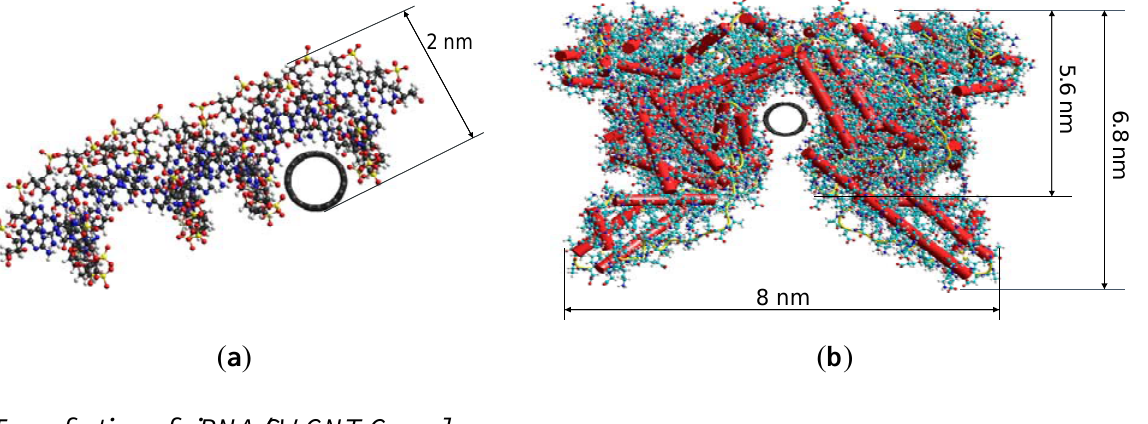
Figure 3. HyperChem model of ( a ) siRNA complexed to SWCNT and ( b ) human serum albumin complexed to SWCNT with diameter distances